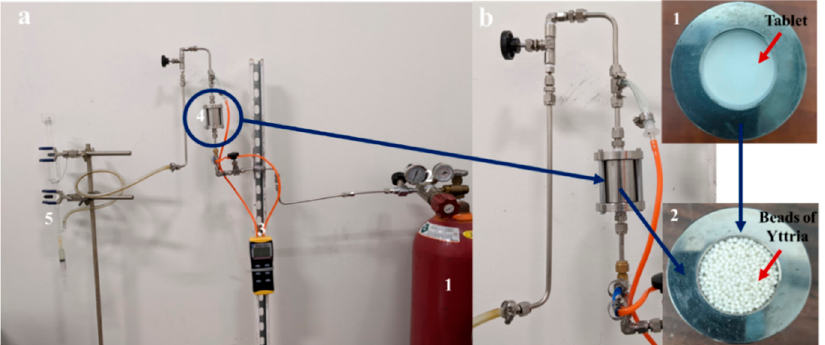
Figure 2. ( a ) Setup for gas permeability measurement in an MCC PH101 tablet. ( b ) Picture showing the ( b1 ) tablet in the die and ( b2 ) the yttria beads used to fill the die on top of the tablet.